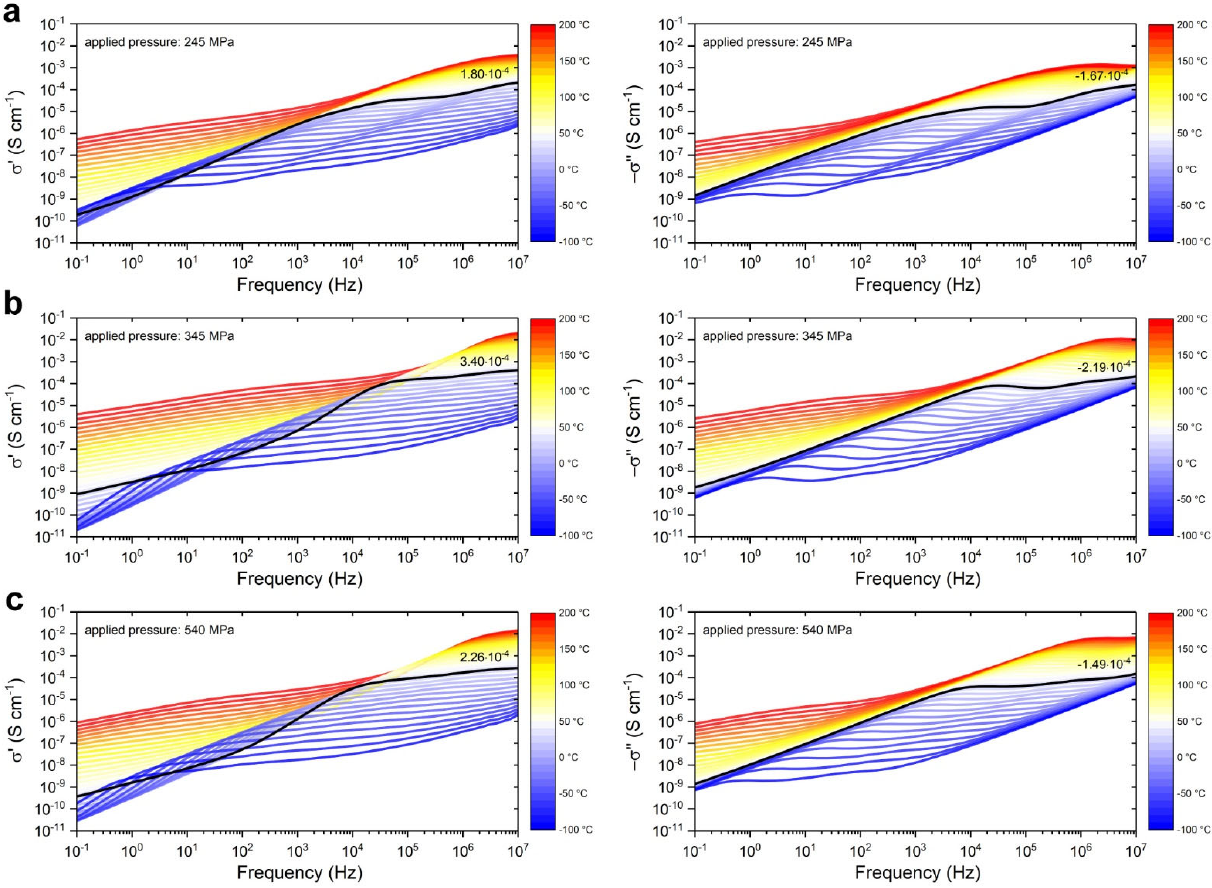
Figure 7. Real and imaginary components, σ ’ and σ ’’ respectively, of conductivity scanned over the broadband frequency range of 10 − 1 to 10 11 Hz and for temperatures ranging from 200 ◦ C to − 100 ◦ C. Scans for NASICON pellets assembled by applying isostatic pressure levels of ( a ) 245 MPa, ( b ) 345 MPa, and ( c ) 540 MPa are displayed. Temperature profiles were plotted according to the common colormaps displayed on the right of figures; scans corresponding to RT (25 ◦ C) are highlighted in bold, along with ac conductivity values recorded at the highest frequency levels of the frequency-dependent dispersion zones for RT.